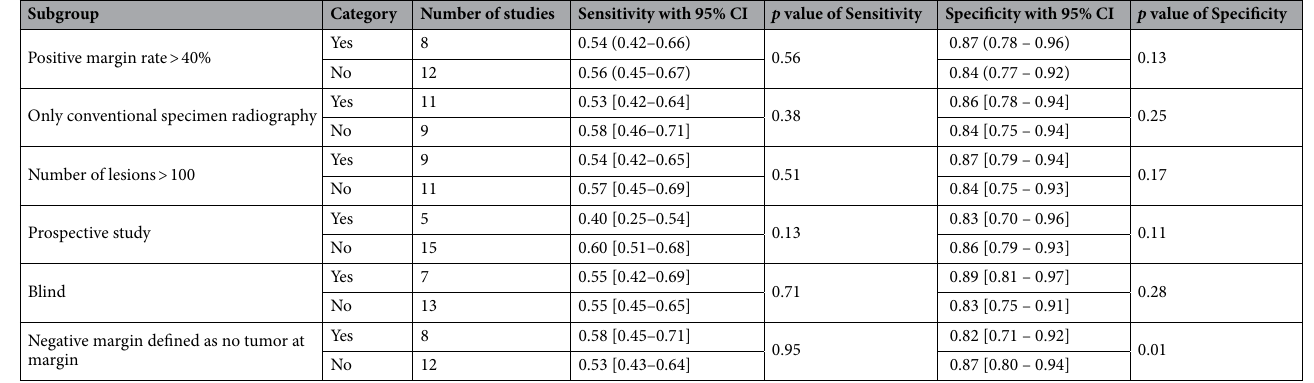
Table 3. Univariable meta-regression and subgroup